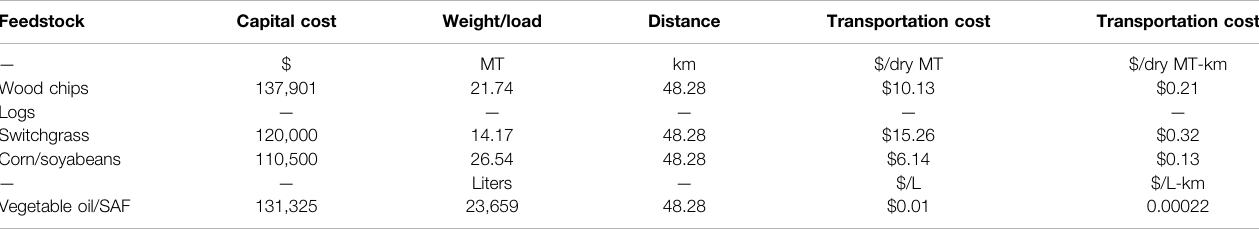
TABLE 3 | Trucking cost of biomass feedstock ($/unit-km) (2017$). Feedstock